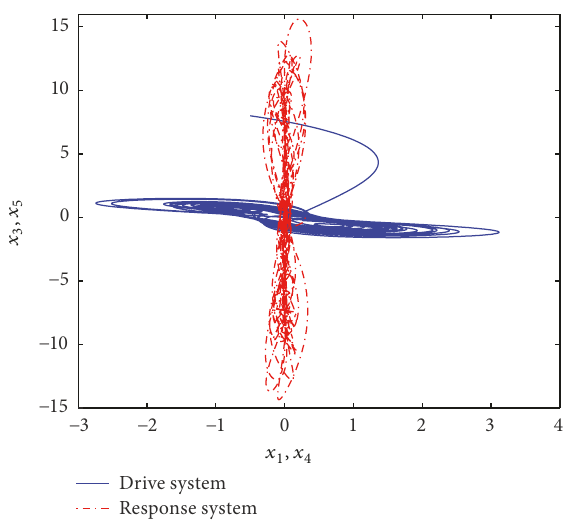
Figure 2: MFPS errors of system (30) with ℎ 1 (𝑡) = 0.1 cos (2𝑡) and ℎ (𝑡) = 3 √ 𝑡 . 2